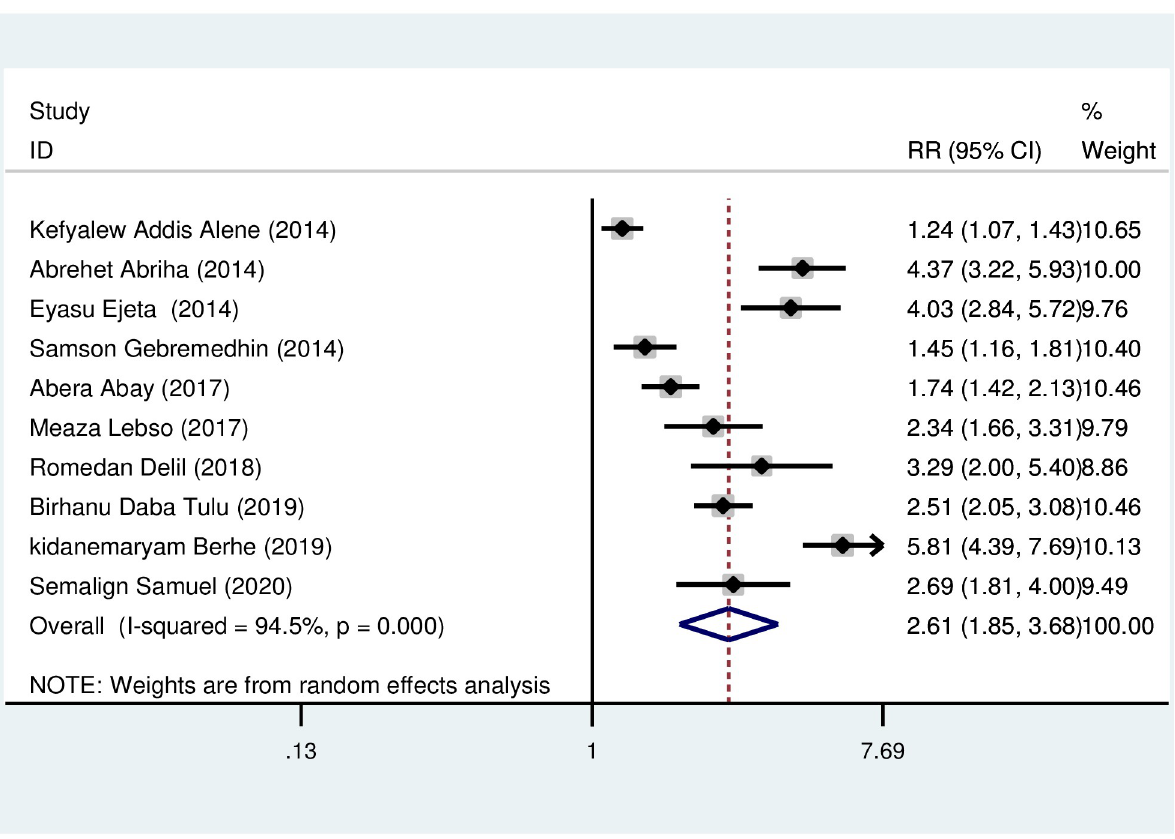
Fig 4. Association of low dietary diversity with anemia during